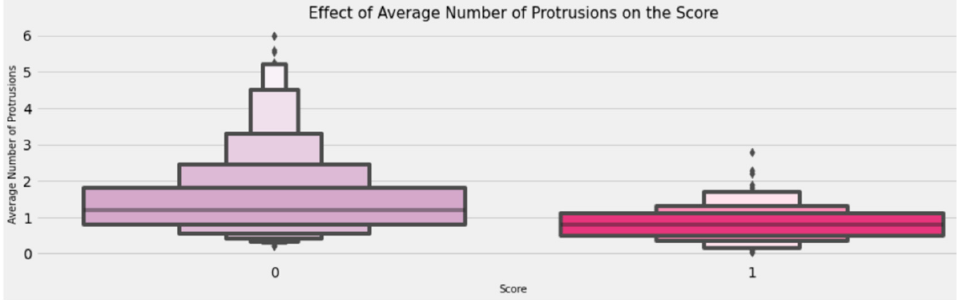
Figure 9. Effect of average number of protrusions per observation on the target class.